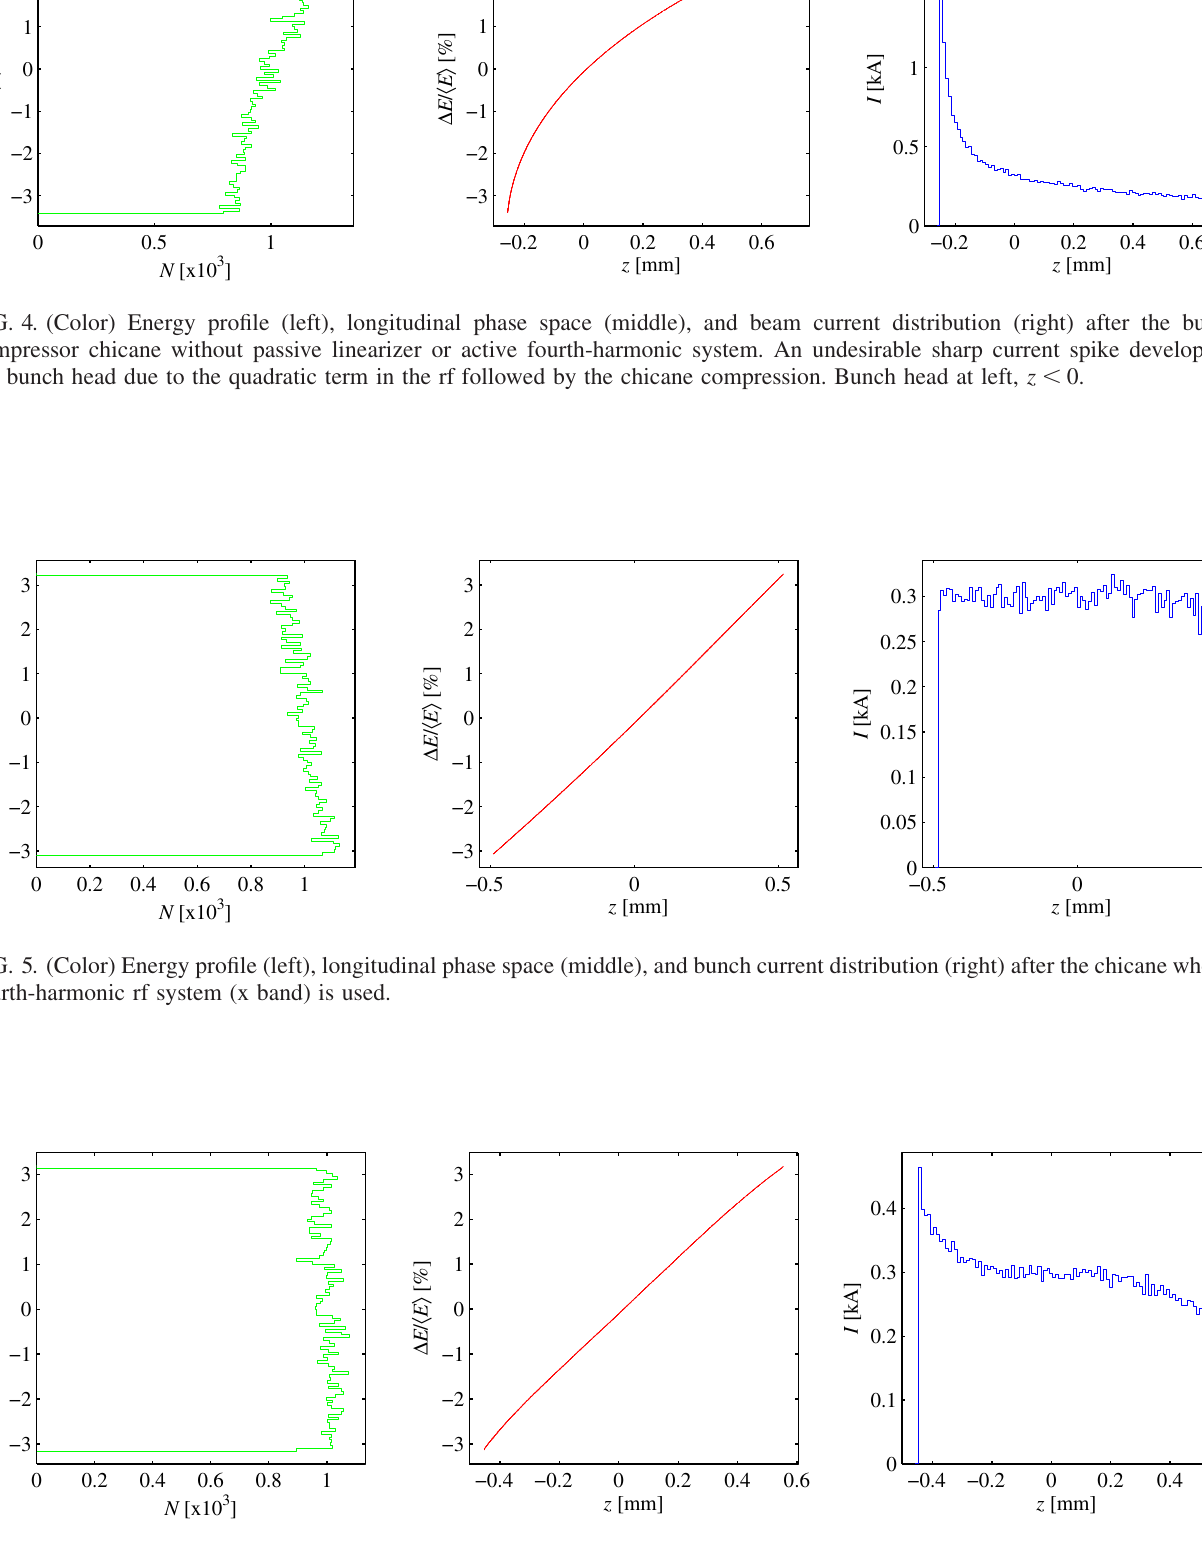
FIG. 6. (Color) Energy profile (left), longitudinal phase space (middle), and bunch current distribution (right) after the chicane when the passive linearizer is used to compensate the quadratic term. The goal is to have the compression factor C ¼ 3 : 5